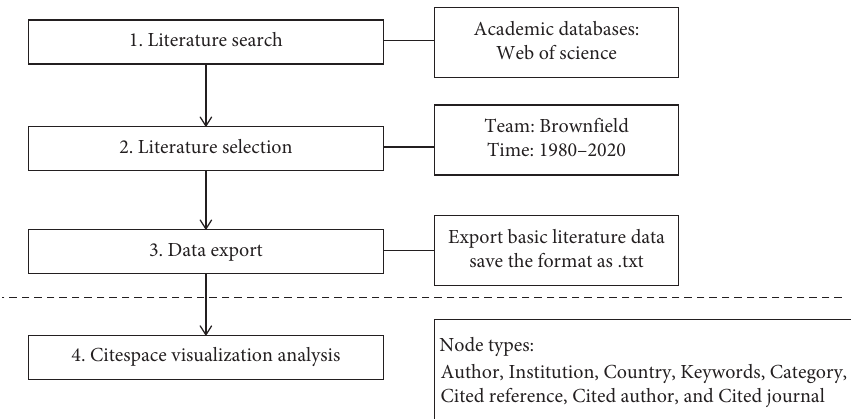
Figure 1: Flow diagram of the bibliometric analysis performed with